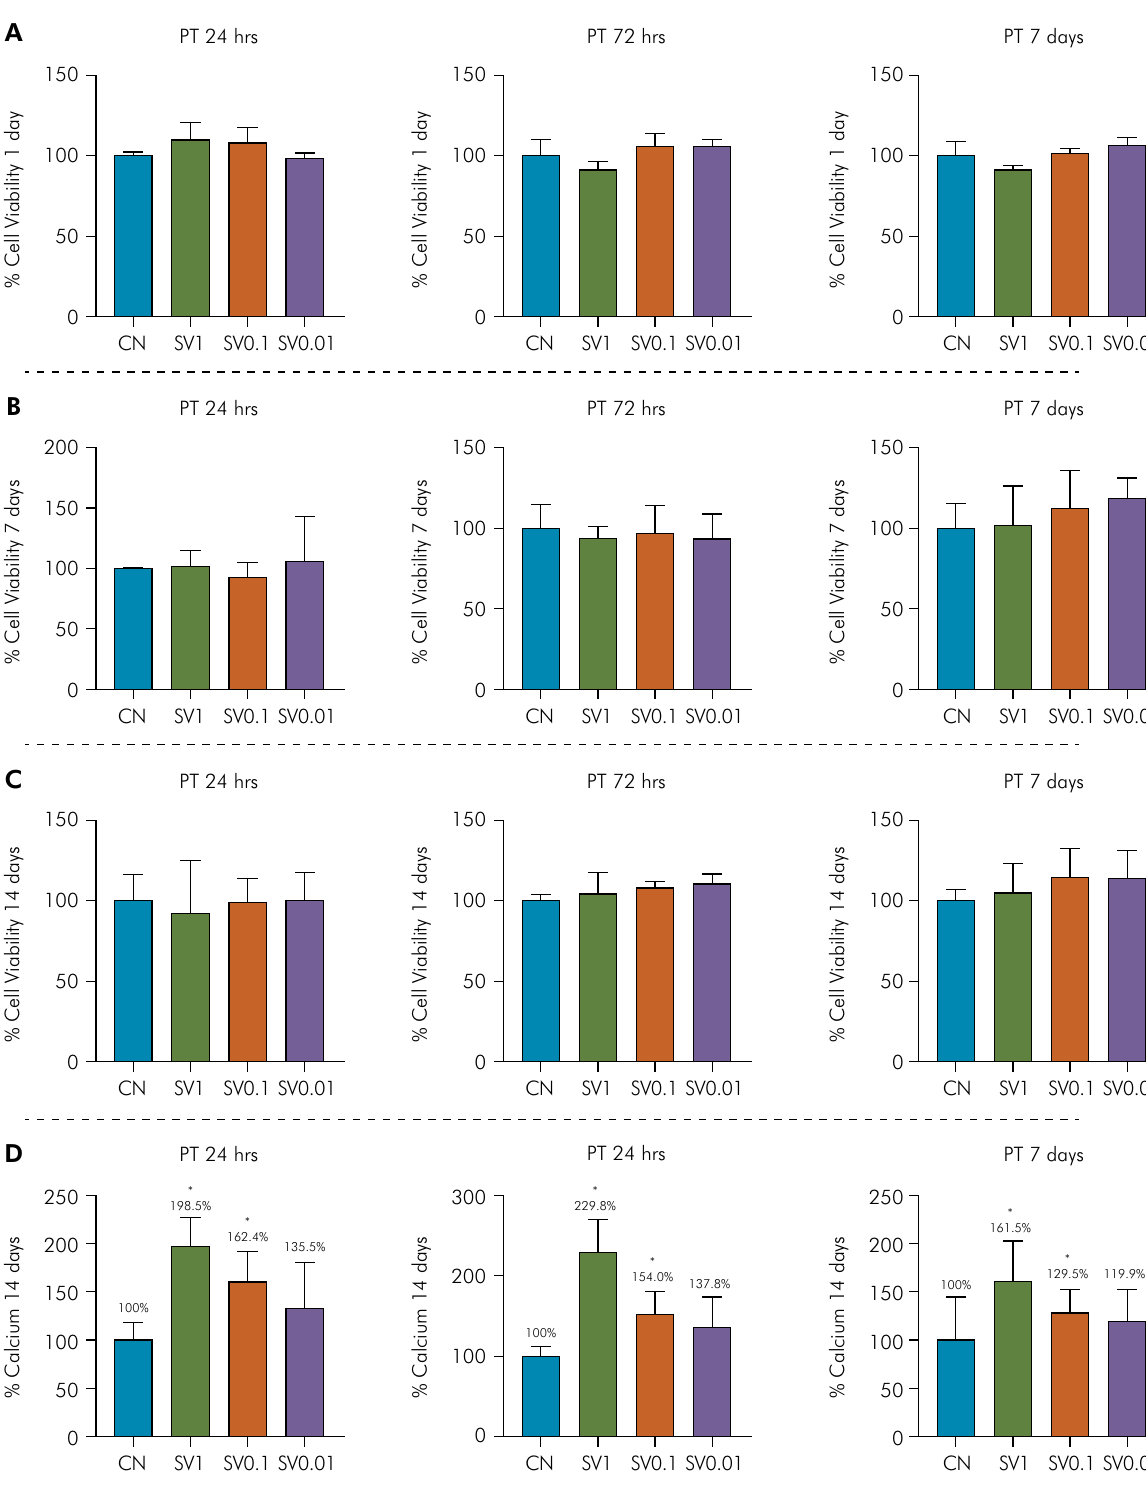
Figure 2. SV Screening Assay. Mean bar graph (standard deviation) of cell viability values at 1 (a), 7 (b), and 14 (c) days, and calcium deposition at 14 days (d), according to the experimental groups and pre-treatment periods (PT 24 h, 72 h, and 7 days). Values represent mean and * indicate statistically significant differences from the negative control group (CN) (one-way analysis of variance (ANOVA) /Dunnett’s. n = 6, p <